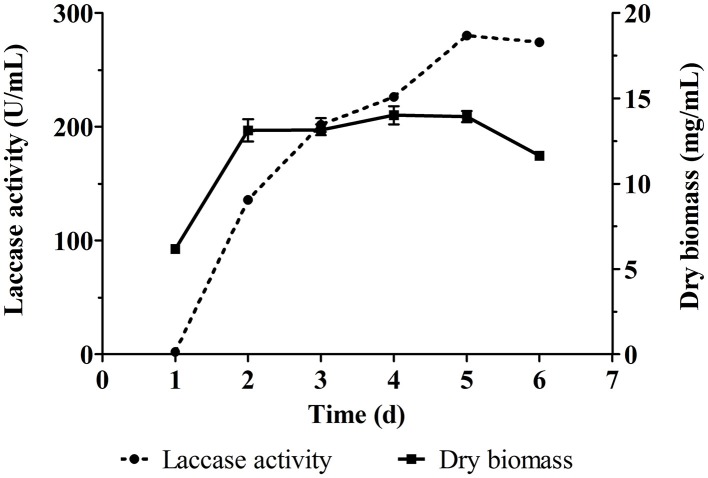
Laccase production and biomass accumulation of Cerrena sp. HYB07. Fermentation was carried out in 250 mL Erlenmeyer flasks at 30°C and 200 rpm. The fermentation medium (50 mL) was inoculated with the second seed culture at the concentration of 8% (v/v). The fermentation medium contained (g L−1): maltodextrin, 60; peptone, 10; ammonium tartrate, 1.6; KH2PO4, 6; MgSO4·7H2O, 4.14; CaCl2, 0.3; NaCl, 0.18; CuSO4·5H2O, 0.0625; ZnSO4·7H2O, 0.018; and vitamin B1 0.015.